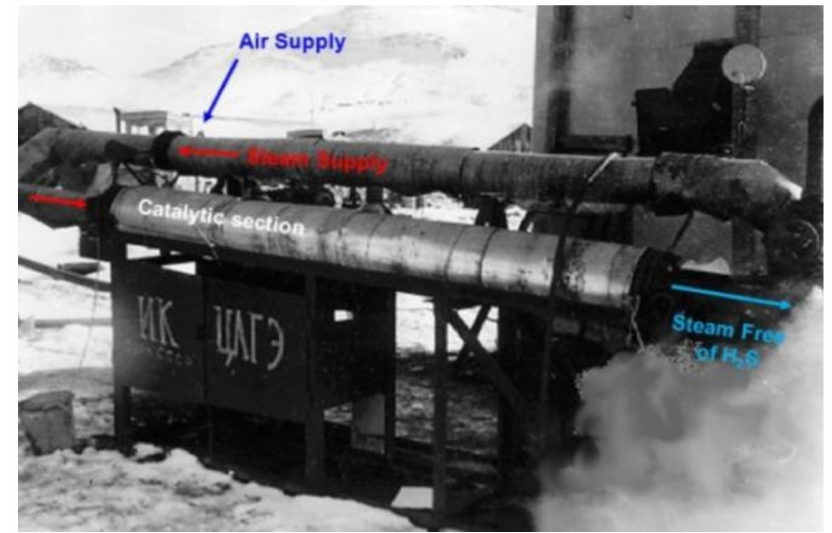
Figure 18. Pilot plant for H 2 S removal from geothermal